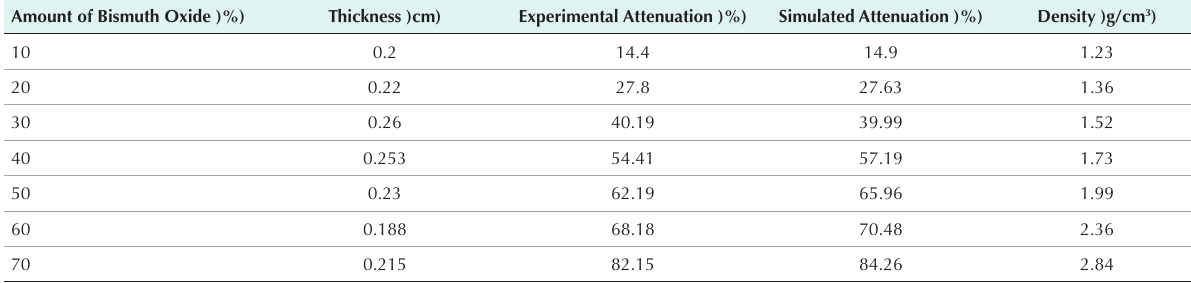
Table 1. The Effect of Bismuth Oxide Content and Thickness on X-Ray Attenuation )24) Amount of Bismuth Oxide )%)